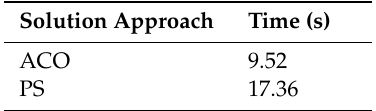
Table 5. Computation time